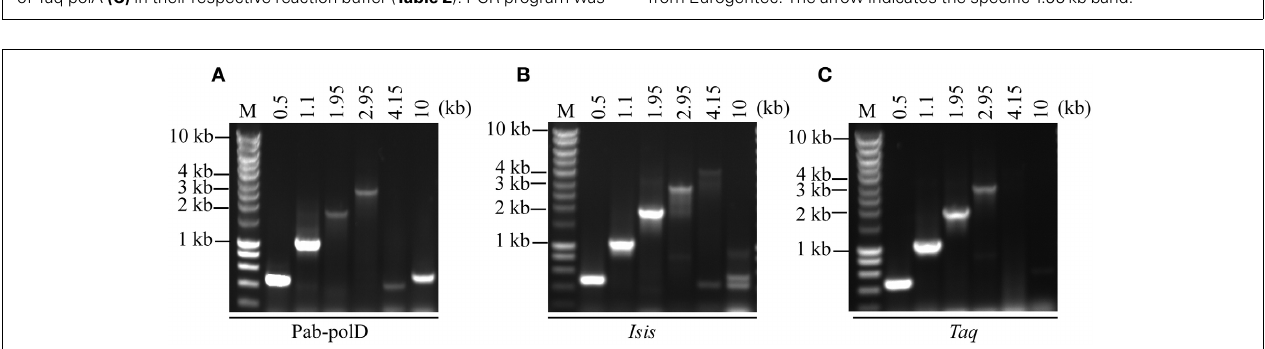
(2min at 94 ◦ C) × 1; (1min at 94 ◦ C, 1min at 58 ◦ C, varying times in seconds as indicated at 72 ◦ C) × 30. Molecular weight markers (M) are SmartLadder LF from Eurogentec. The arrow indicates the specific 1.95kb band.